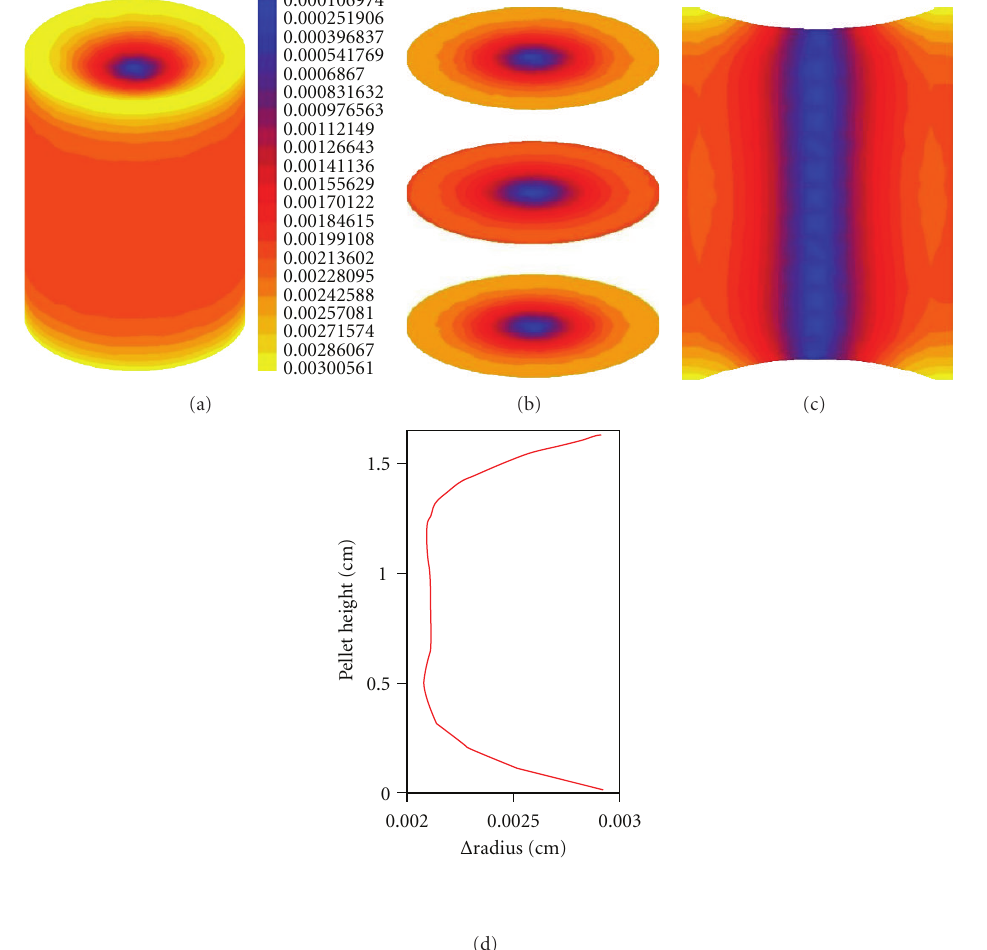
Figure 4: Radial deformations in a CANDU fuel pellet. (a) 3D view of the radial deformations. (b) Three horizontal sections of the radial deformation field. (c) Vertical section through the symmetry axis of the radial deformation field. (d) Radial deformation along a cylinder